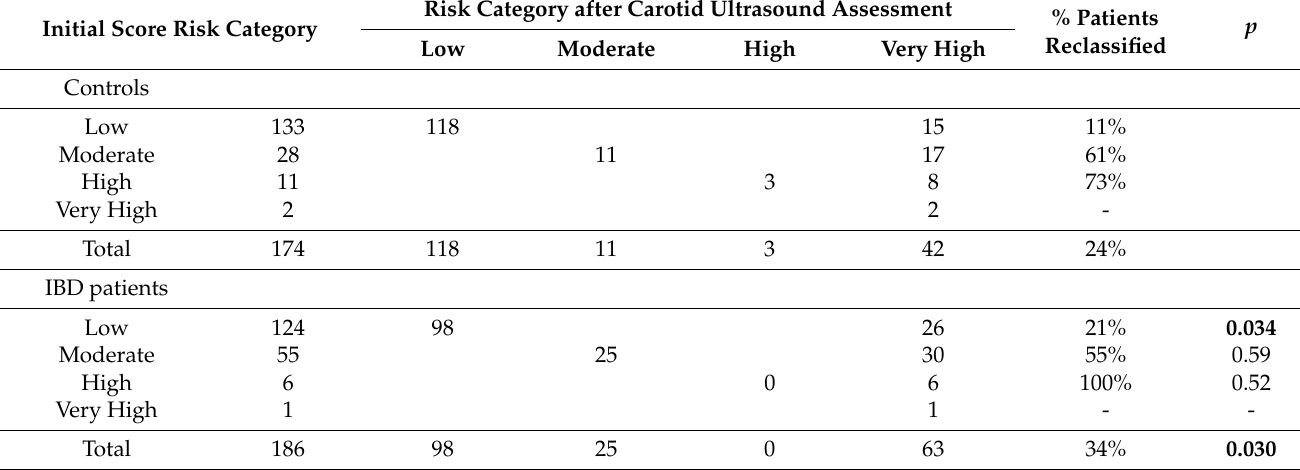
Table 2. Systematic Coronary Risk Evaluation (SCORE) risk category reclassification after carotid ultrasound assessment in patients with inflammatory bowel disease (IBD) and controls. Risk Category after Carotid Ultrasound Assessment % Initial Score Risk Category